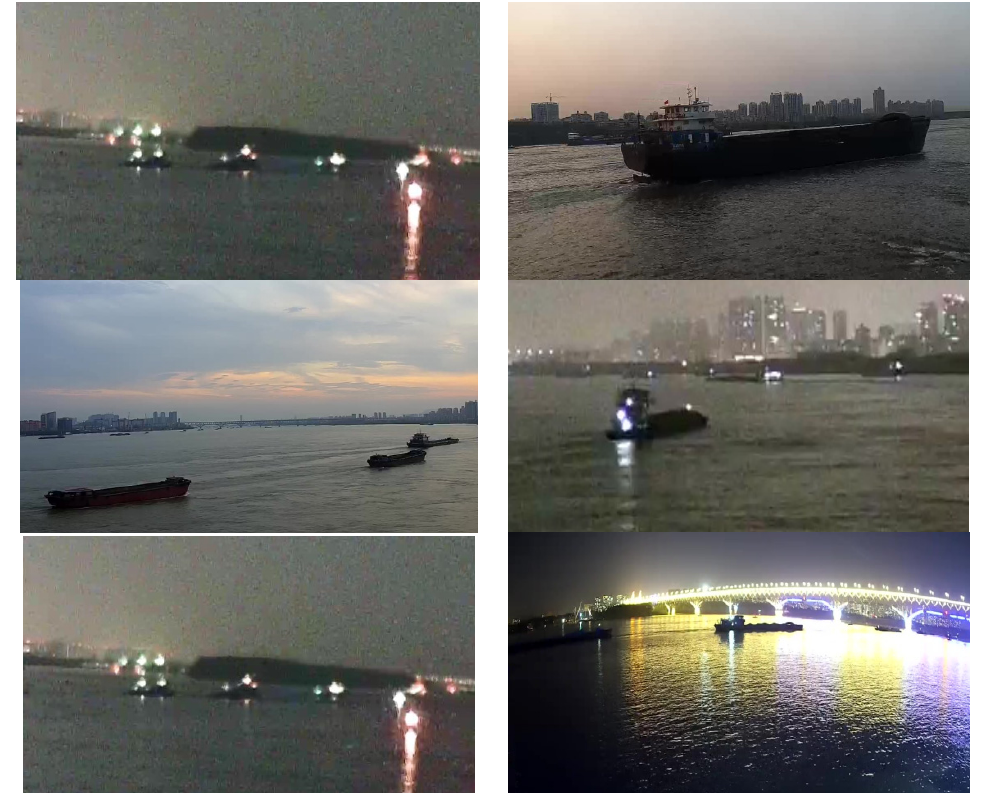
Figure 7. Partial images of ship object in a low-illumination environment.